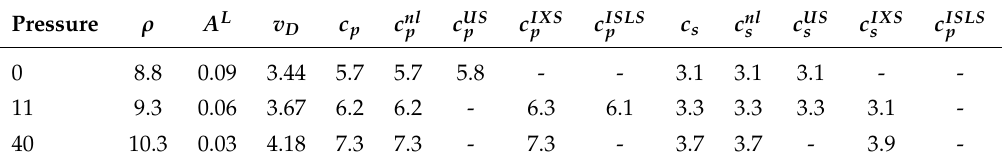
Table A1. The Debye v D and seismic wave speeds c p and c s of cobalt at pressures of zero to 40 GPa. The alloy’s density in g/cm 3 ( ρ is given in column 2 [45]), while the strength of anisotropy ( A L ; [22]), and the Debye speed calculated using Equation (7) and the elements of the elasticity of cobalt ( v D ; [44]) are given in columns 3 and 4. The material’s seismic wave speed ( c p ; column 5) is compared against longitudinal wave speeds obtained using the full non-linear equations of Equation (21) ( c nl p ; column 6), and experimentally measured values determined using ultrasonics ( c US p ; column 7; [46] ), inelastic X-ray scattering ( c IXS p ; column 8; [45]), and impulsive stimulated light scattering ( c ISLS p ; column 9; [47]). Columns 10 through 14 are the same as columns 5 through 9 except for shear/transverse wave speeds.